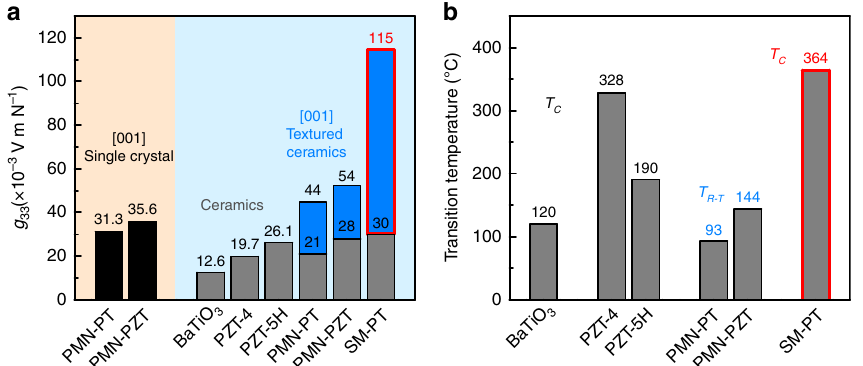
Figure 1 | Comparison of piezoelectric voltage coefficient and phase transition temperature. ( a ) Piezoelectric voltage coefficient ( g 33 ) for well-known perovskite structured piezoelectric oxide single crystal (PMN-PT 13 and PMN-PZT 13 ) and ceramics (BaTiO 3 (ref. 4), PZT-4 (ref. 4), PZT-5H 4 , PMN-PT 9 , PMN-PZT 10 and SM-PT). Black bars: single crystal; gray bars: ceramics; blue bars: textured ceramics; blue bar with red border: textured SM-PT in this study. ( b ) phase transition temperature above room temperature ( T R-T : rhombohedral-to-tetragonal ferroelectric phase transition; T c : Curie temperature) for well-known perovskite structured piezoelectric oxide materials (BaTiO 3 (ref. 4), PZT-4 (ref. 4), PZT-5H 4 , PMN-PT 13 , PMN-PZT 13 and SM-PT). Blue bar with red border: textured SM-PT in this